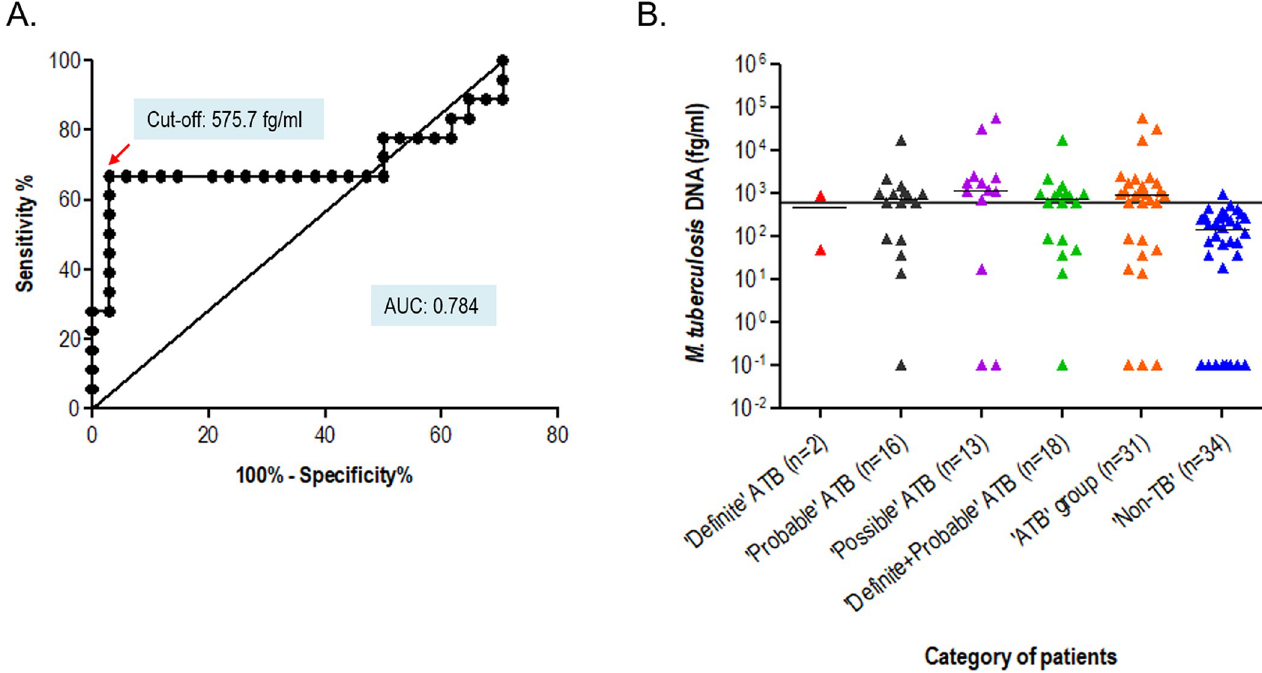
Fig 3. Detection of circulating cell-free M . tuberculosis DNA in ascitic fluid samples by cfMTB-DNA qPCR assay. A.) ROC curve generated from the cell- free MTB-DNA amount quantified from ascitic fluid samples of ‘Definite and Probable’ ATB vs. ‘Non-TB’ patients. B.) Scatter plot of M . tuberculosis (fg/ml) in each categorized group. The black horizontal line across the scatter plot denotes the cut-off value of 575.7 fg/ml set by ROC curve analysis of ‘Definite and Probable ATB’ group (combined) vs . ‘Non-TB’ disease group. The black line in each data set denotes the median value.